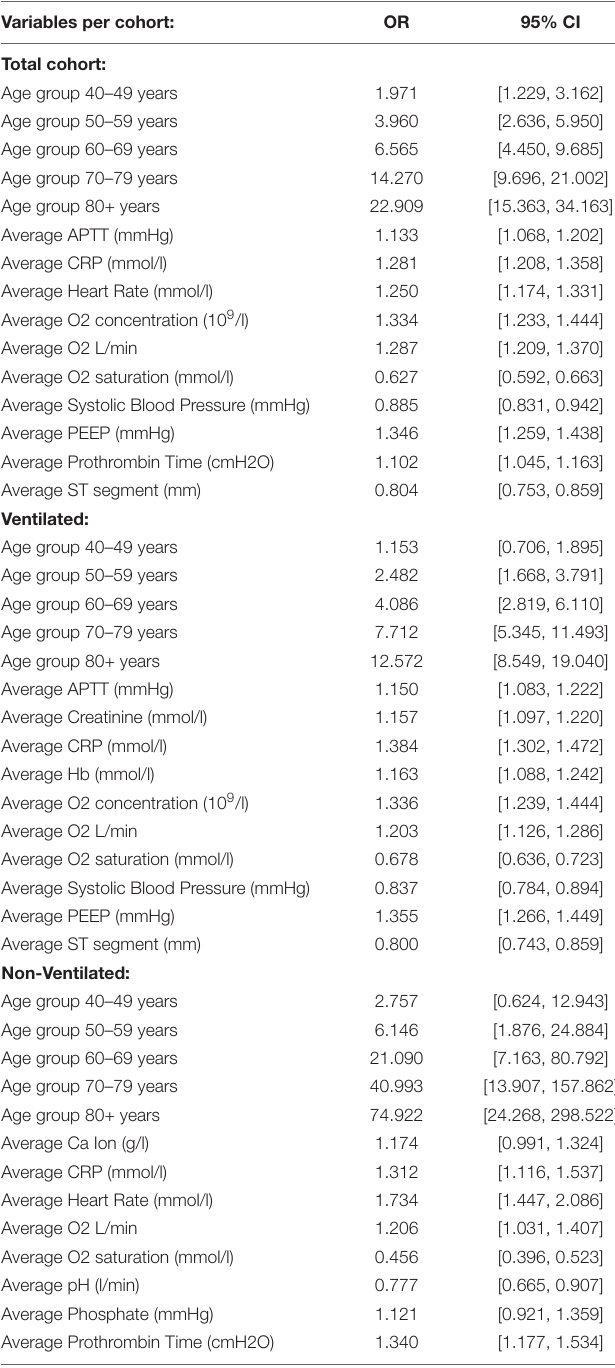
TABLE 2 | Detailed information of the variables odd ratios (OR) and their corresponding 95% confidence intervals (CI) for each of the developed